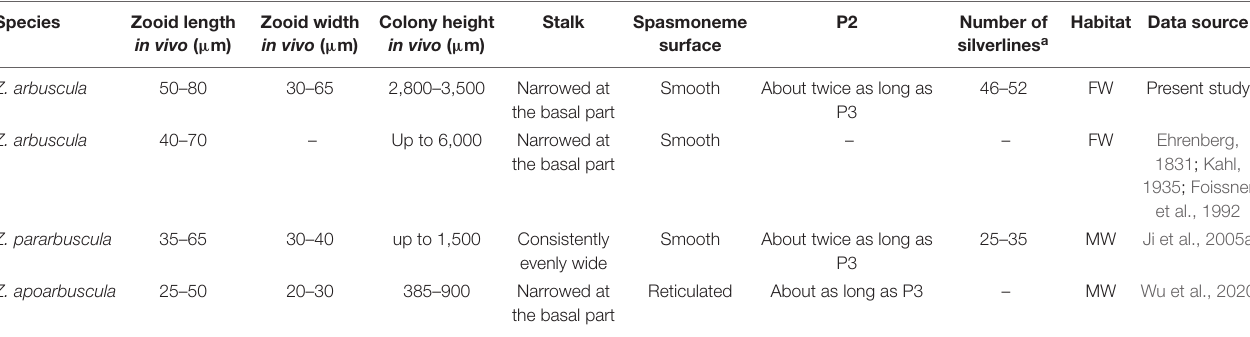
TABLE 1 | Morphometrical characterization of five colonial sessilid peritrich species based on specimens in vivo (except where stated). Character Species